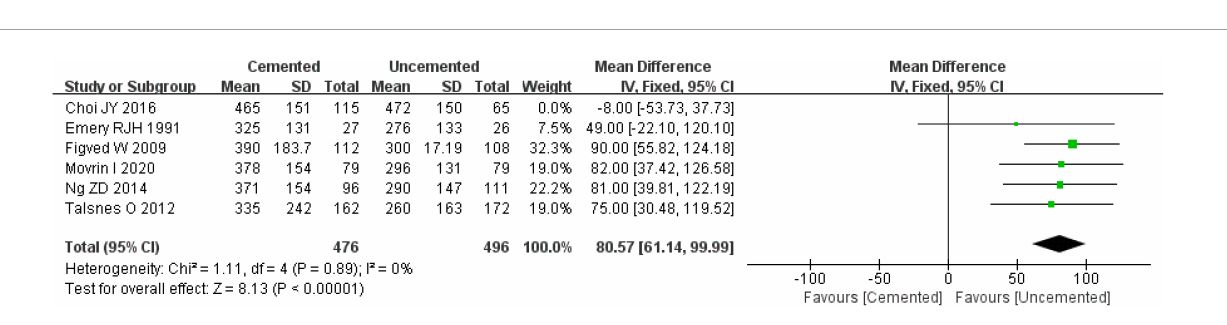
FIGURE5 Forest plot for comparison of intra-operative blood loss between cemented bipolar hemiarthroplasty (CBH) group and uncemented bipolar hemiarthroplasty (UCBH) group.